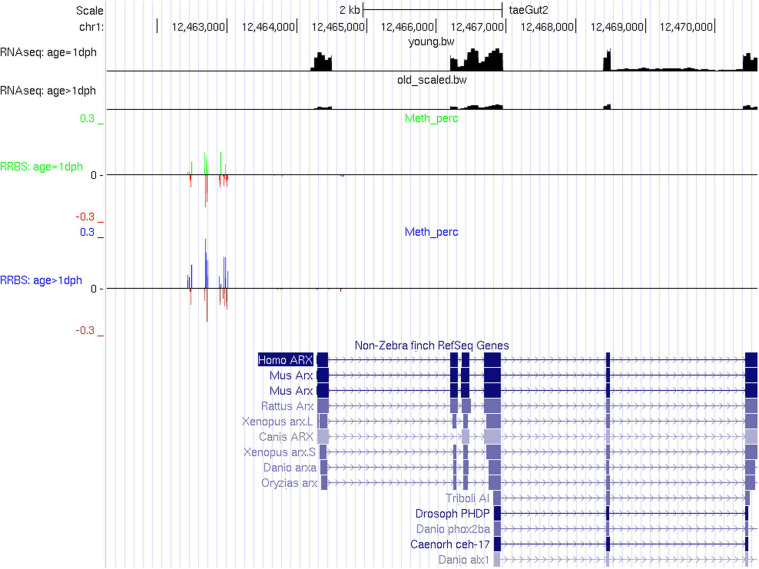
RNA-Seq and RRBS tracks for the gene ARX. In the RRBS tracks, the average methylation rate is provided as a positive number for significantly methylated CpGs and as a negative number for insignificantly methylated CpGs.